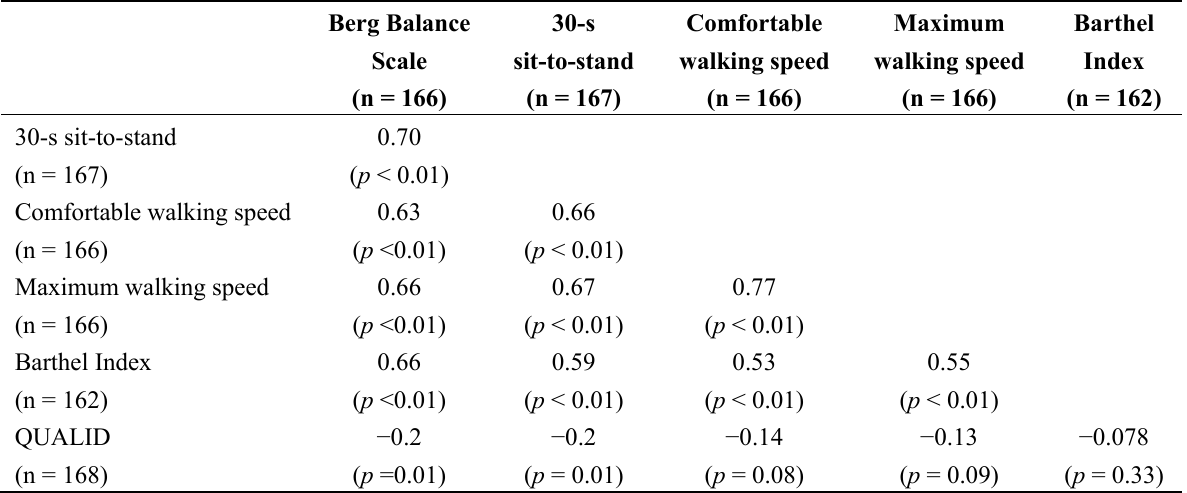
Table 2. Correlation between the different physical function measures and QUALID (The Pearsons Correlation Co-efficients).